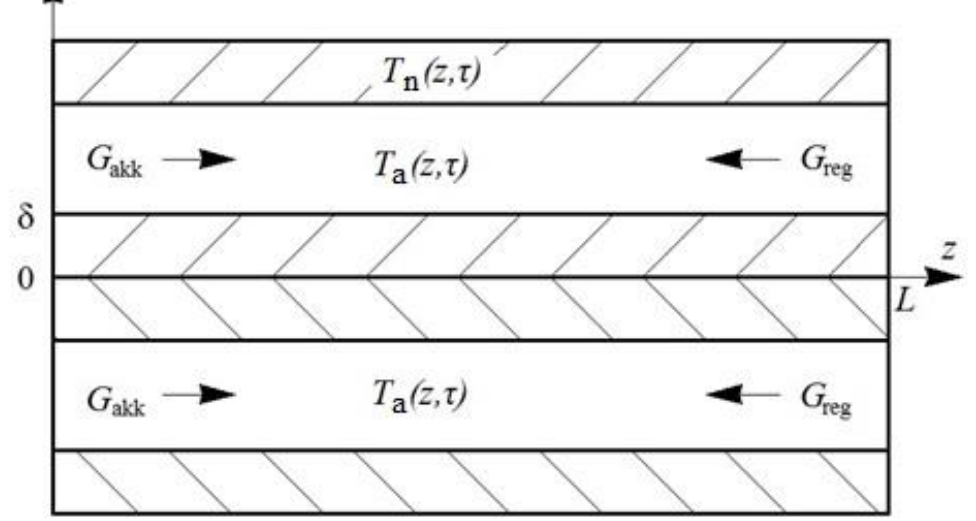
Figure 1. Schematic of the SSRHE regenerative nozzle adjacent channels: δ is the channel wall thickness, G akk and G reg is mass air flow at the heat accumulation and regeneration stages.